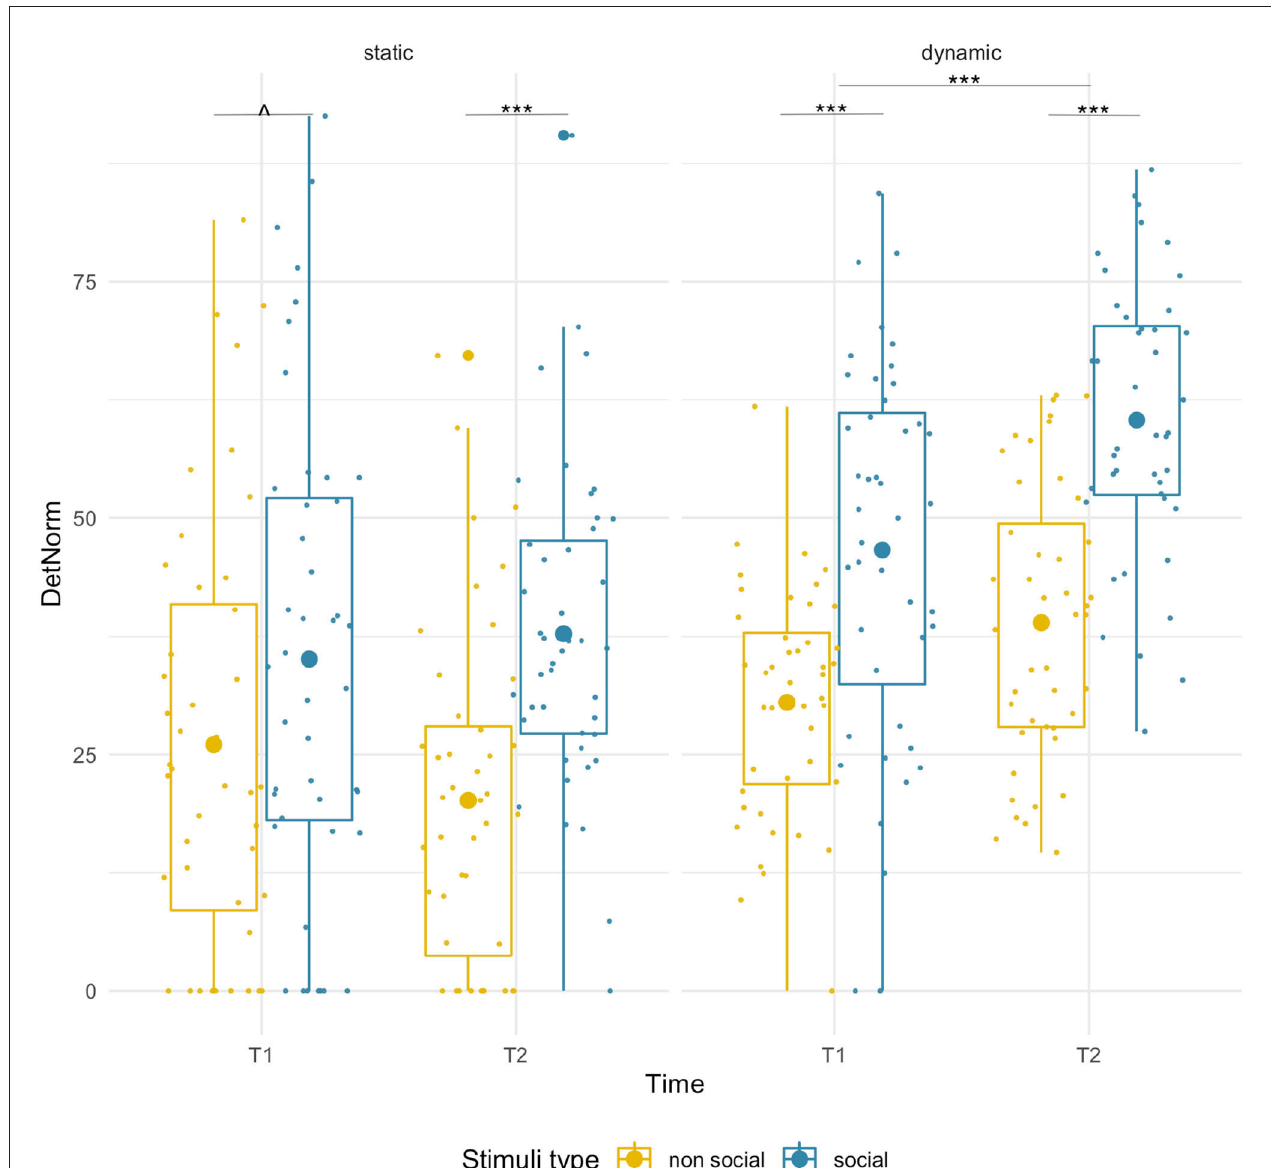
FIGURE 3 | Box plots with individual data showing distribution of normalized determinism for each stimulus type. The big dot inside each box indicates the mean value. Significant differences marked with asterisks: **** p < 0.001; ∧ p = 0.55.